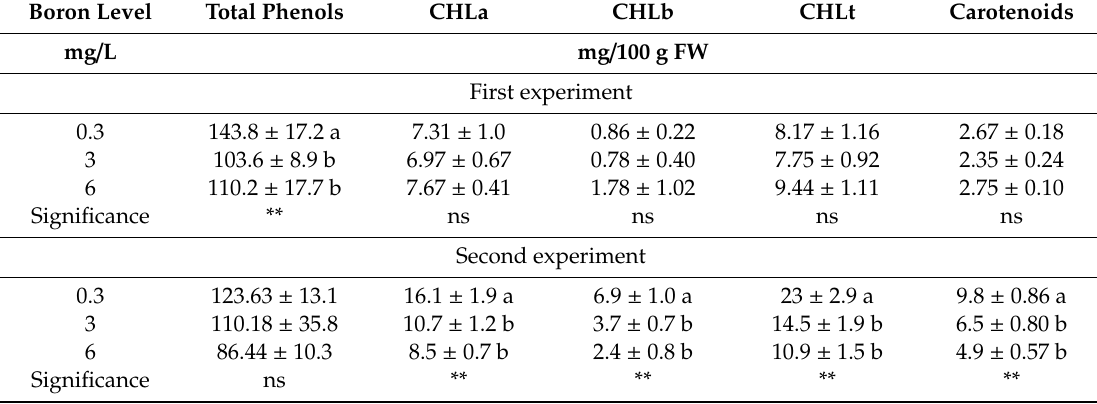
Table 4. E ff ects of di ff erent boron levels in the nutrient solution on the content of total polyphenols, chlorophyll (A and B), and carotenoids in the edible parts of wild (first experiment) and commercial (second experiment) purslane.